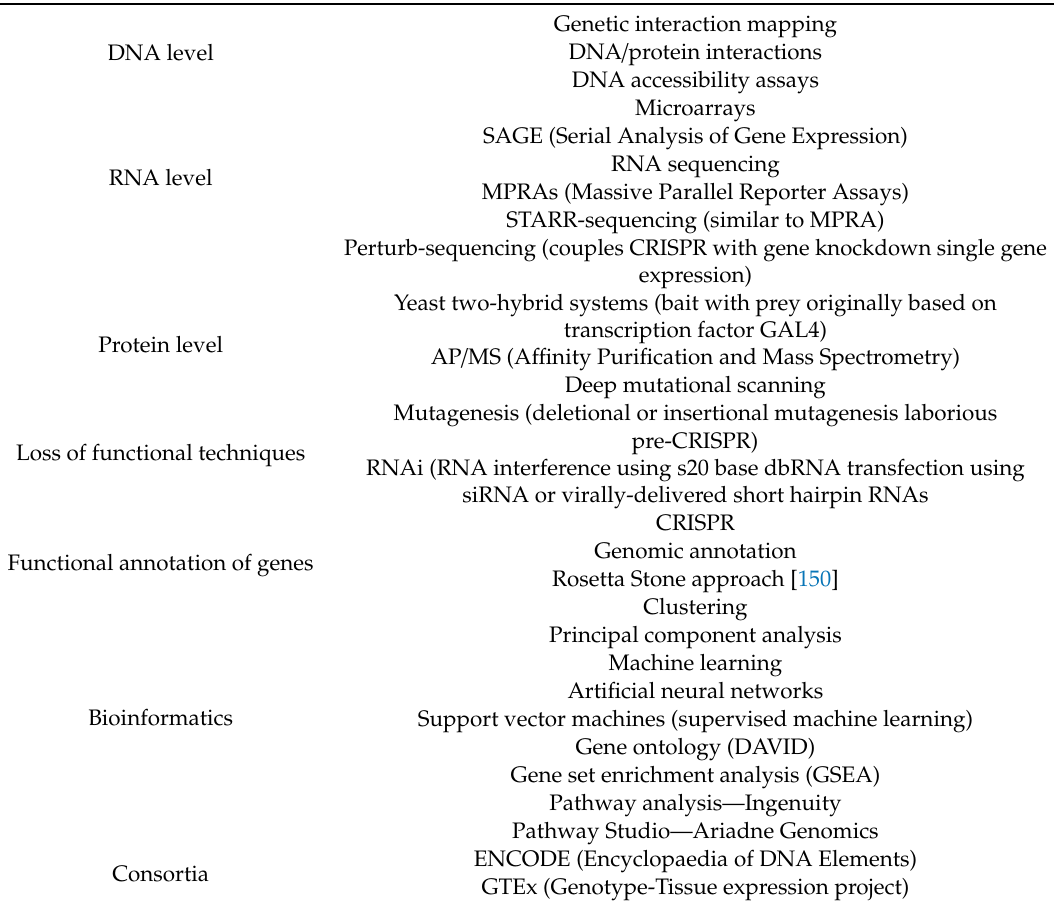
Table 4. Functional Characterisation of